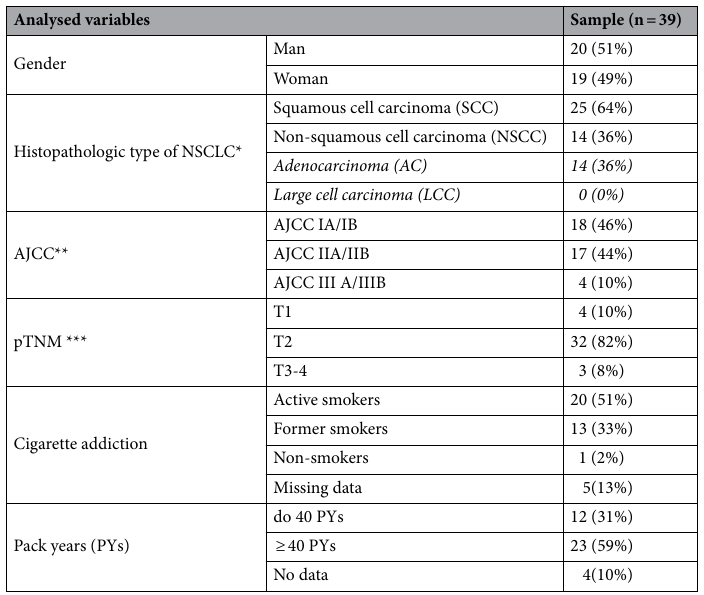
Table 3. Histopathological summary of NSCLC samples. Legend as follows: * NSCLC non-small cell lung cancer, ** AJCC American Joint Committee on Cancer Staging, *** pTNM post-operative Tumour Node Metastasis